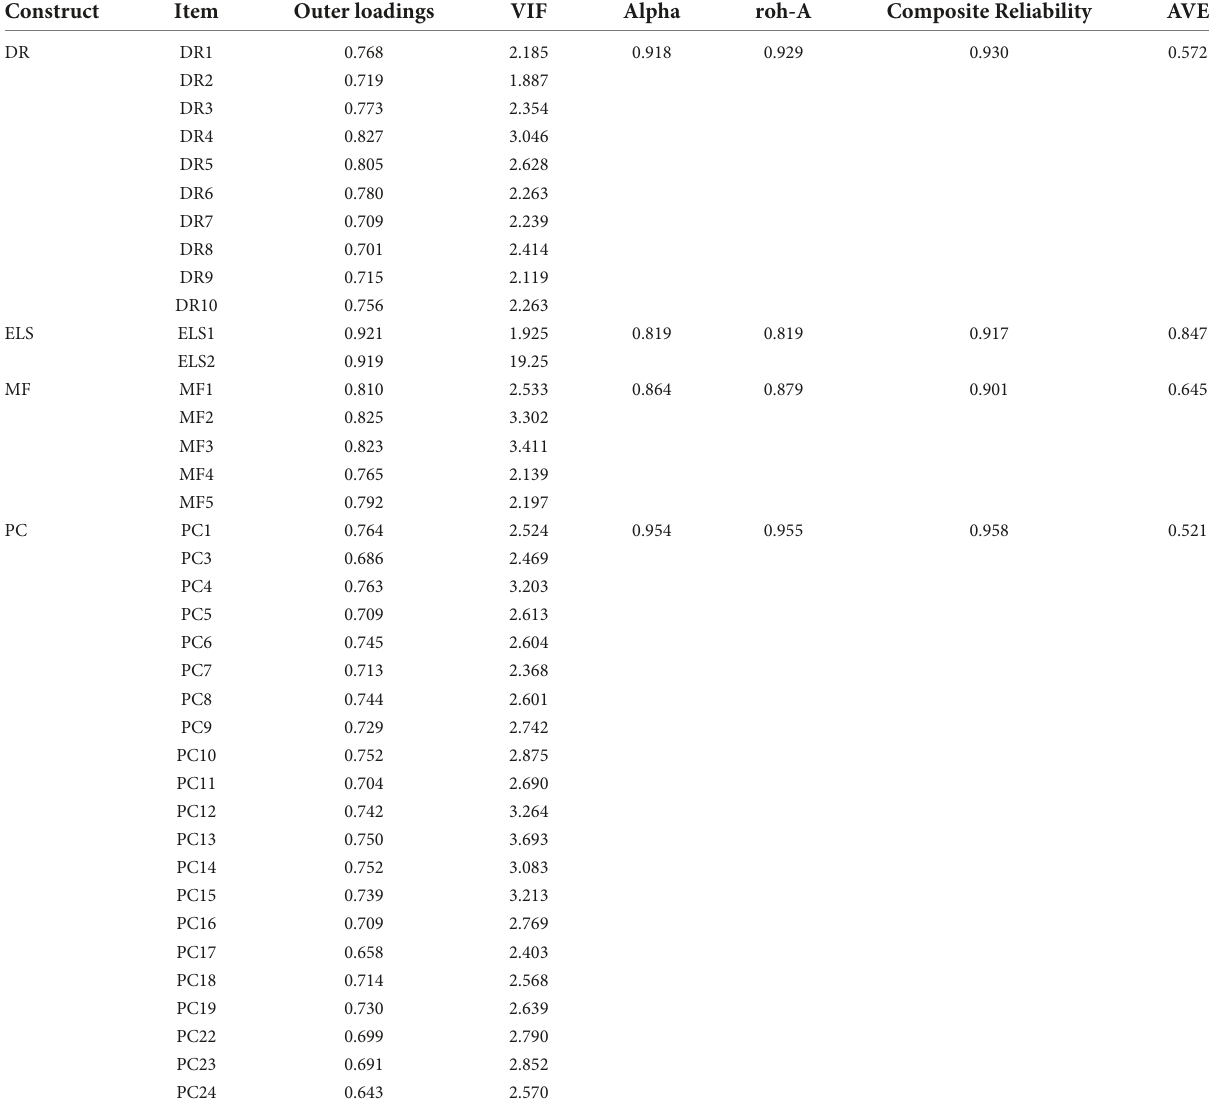
TABLE 1 Outer loadings reliability and convergent validity of the study